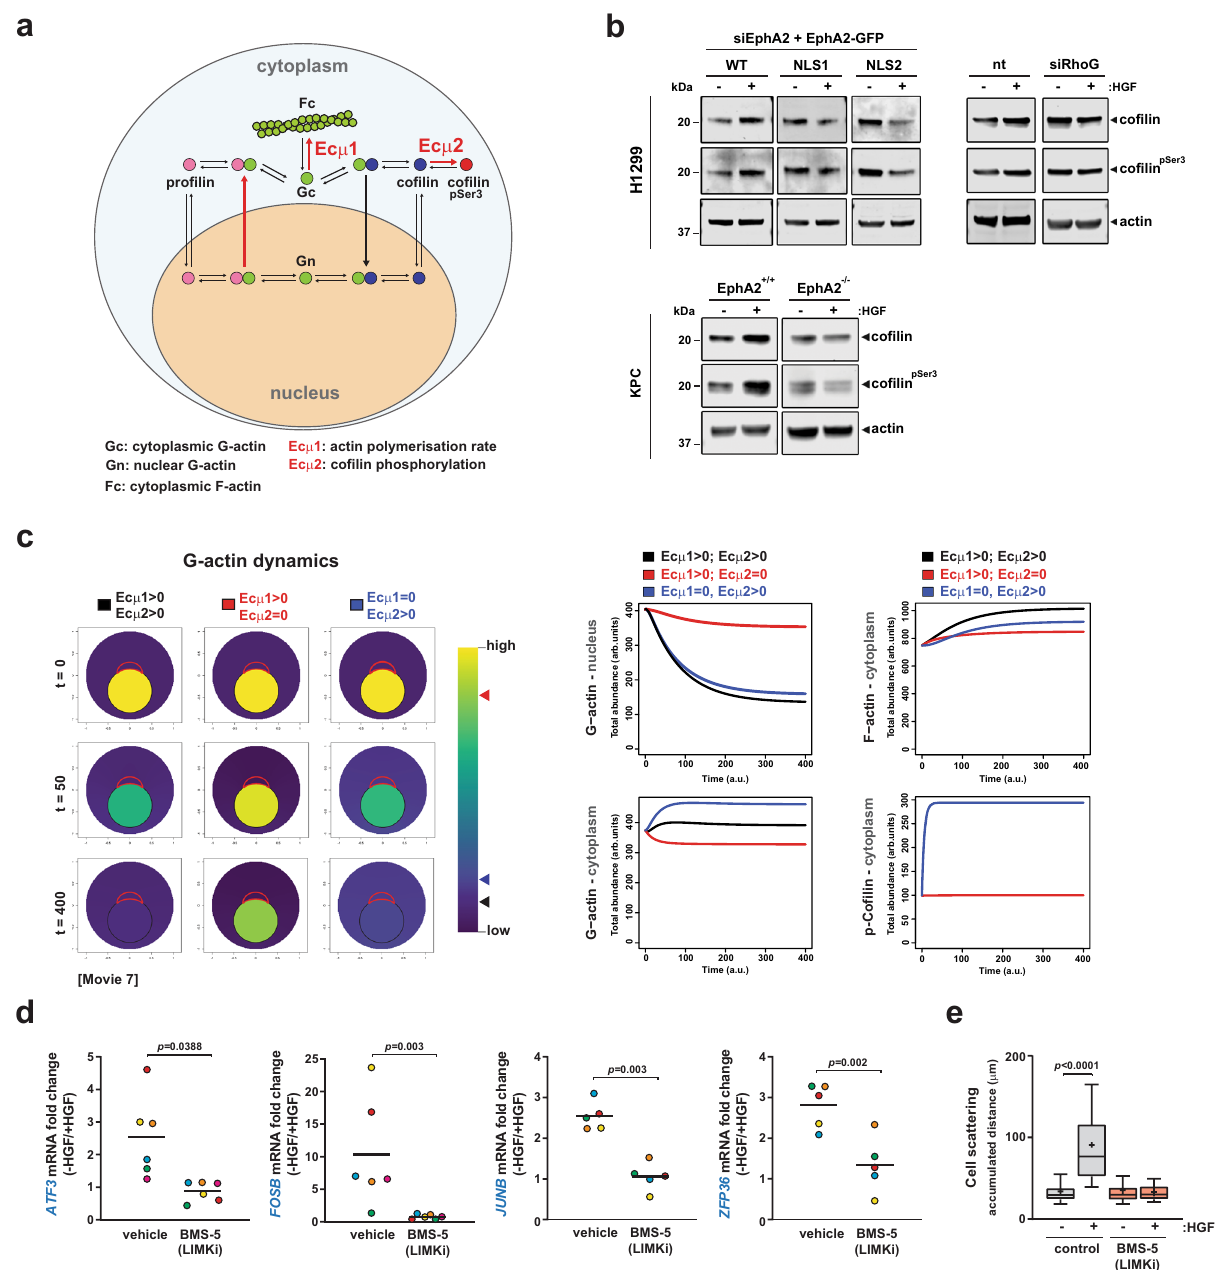
Fig. 7 Co fi lin phosphorylation controls nucleocytoplasmic actin dynamics and gene expression. a Schematic of pathways downstream of EphA2 in fl uencing nucleocytoplasmic actin dynamics. Rates of cytoplasmic actin polymerization and co fi lin phosphorylation are denoted by E c µ 1 and E c µ 2, respectively. b H1299 cells were transfected with siRNAs targeting RhoG (siRhoG) or control (nt), and EphA2 knockdown H1299 cells were transfected with rescue vectors for wild-type EphA2 (WT), EphA2 NLS1 (NLS1) or EphA2 NLS2 (NLS2). PDAC-derived cell lines were from KPC mice (KPC EphA2 + / + ) or EphA2-knockout KPC mice (KPC EphA2 − / − ). Levels of co fi lin and phospho-co fi lin (co fi lin pSer 3 ) following HGF treatment were determined by western blotting. c Nucleocytoplasmic actin dynamics were modelled according to the schematic in a . The cell is modelled as two static circular compartments representing the cytoplasm and nucleus (see Supplementary Fig. 5a). The area of in fl uence of nuclear-captured EphA2 is delimited with a red line and G-actin levels are represented by the Viridis colour palette. EphA2-dependent actin polymerization (E c µ 1) and co fi lin phosphorylation (E c µ 2) were ‘ initiated ’ at t = 0 and movies made from this (Supplementary Movie 7). Stills (at t = 0, 50 and 400) from these movies and graphs denoting the changes in G-actin (nuclear and cytoplasmic), F-actin and phospho-co fi lin levels are displayed. This dynamic model indicates that shutdown of co fi lin phosphorylation (E c µ 1 > 0; E c µ 2 = 0; red), but not actin polymerization (E c µ 1 = 0; E c µ 2 > 0; blue), opposes depletion of nuclear G-actin. d Cells were treated with or without HGF for 20 min in the absence or presence of LIMK inhibitor (BMS-5) and levels of the indicated SRF target determined as for Fig. 5b. Bar is mean of n = 6 for ( ATF3; FOSB ) and n = 5 ( JUNB , ZFP36 ) independent experiments. Paired data are denoted by dots of the same colour. e Cell scattering was determined as for Fig. 4f, in the presence and absence of LIMK inhibitor (BMS-5). Box and whiskers: 10 – 90 percentile whiskers, + represents mean, black line represents median, n = 3 independent experiments, statistical test is one-way